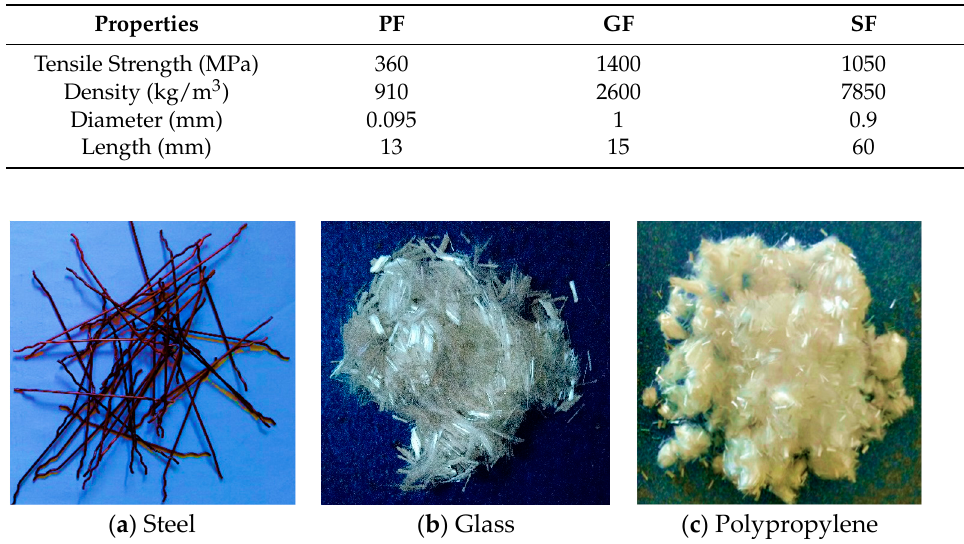
Table 1. Properties of fiber.